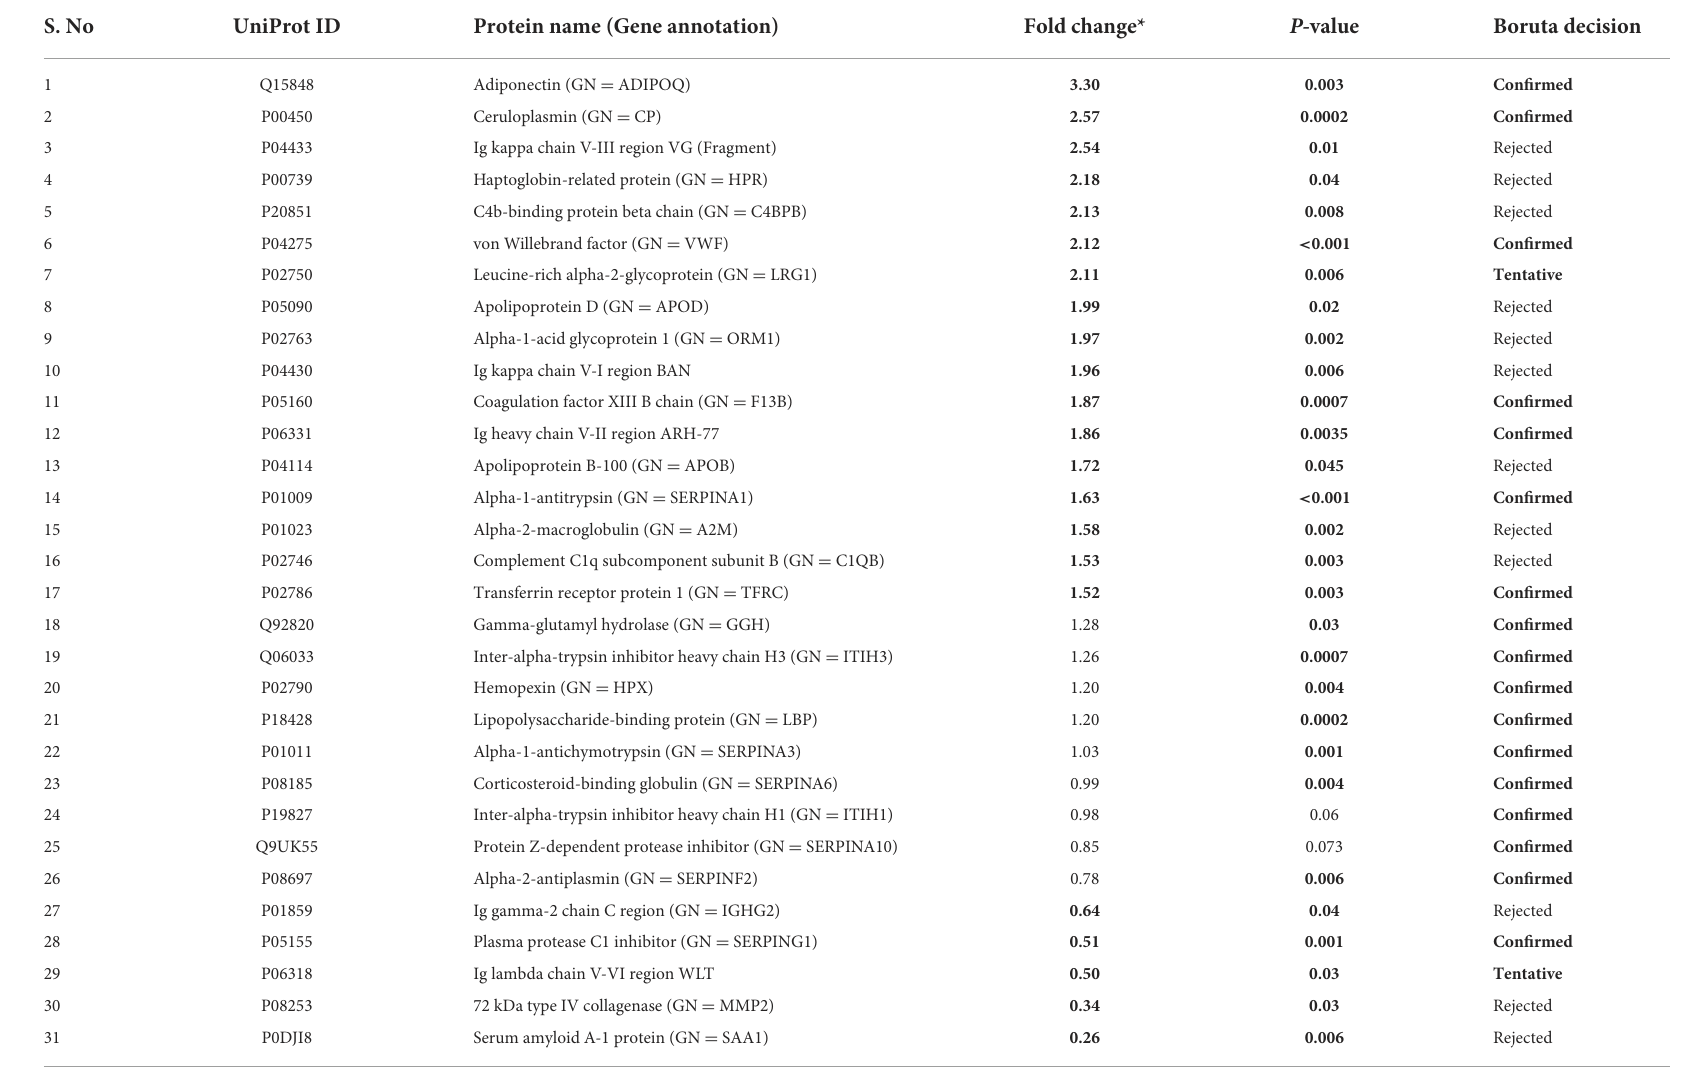
TABLE 2 List of significantly differentially expressed proteins between total stroke and healthy controls within 24h of symptom onset using fold change with p- value and Boruta random forest feature selection criteria. S.